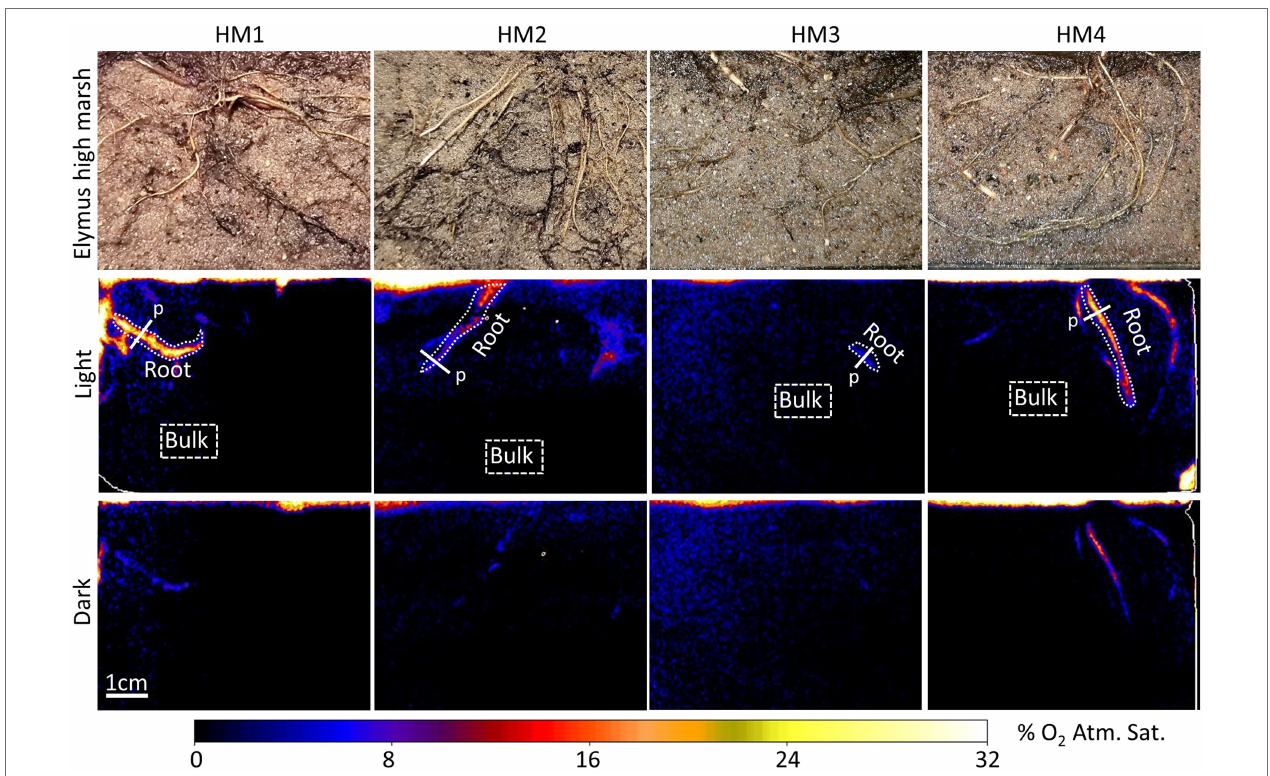
FIGURE 3 | Planar optode images of the O 2 distribution around selected roots of E. athericus – high-marsh ecotype from four independent samples (HM1–HM4), with and without illumination of the aboveground biomass. “Root” indicates specific oxic root zones, and “Bulk” indicates specific areas with bulk anoxic sediment selected for quantitative O 2 measurements shown in Figure 4 . “p” indicates the locations of the concentration profile shown in Figure 5